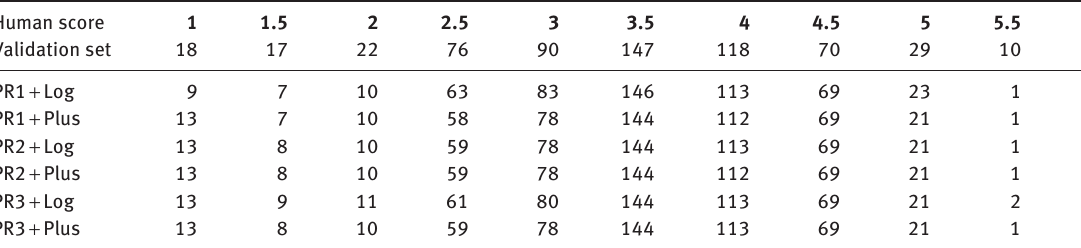
Table 1: Scoring Details of Genuine CLSI (LM: News). Human